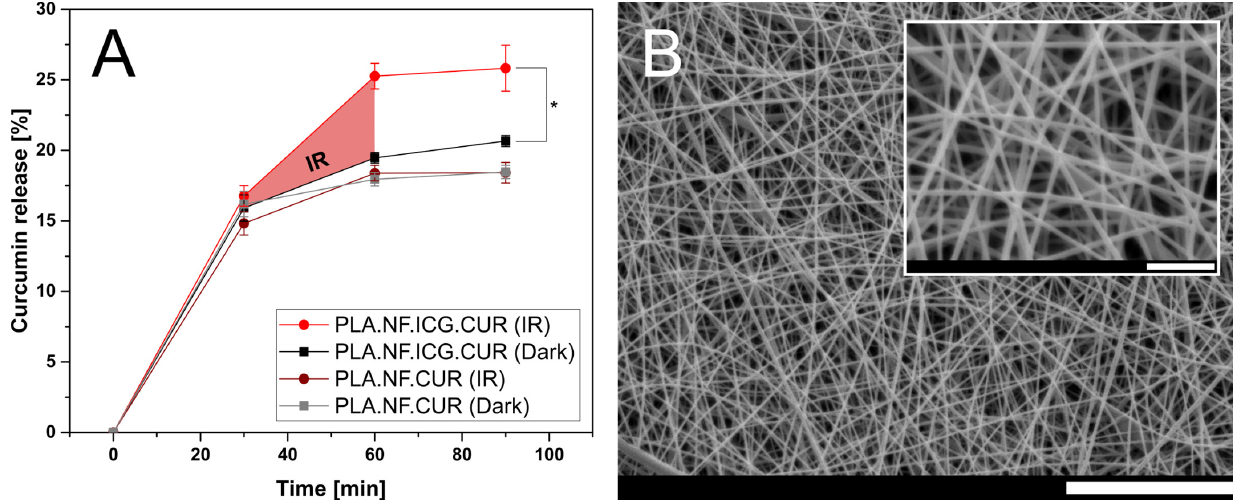
Figure 3. Curcumin release of PLA.NF.ICG.CUR and PLA.NF.CUR plotted as a function of time ( A ), Dark: 90 min incubation under light exclusion, IR: 30 min incubation, followed by 30 min irradiation (810 nm), and 30 min incubation. SEM micrographs of PLA.NF.ICG.CUR after irradiation ( B ). Scale bars represent 20 µm and 4 µm for the inset. Statistical differences are denoted as “*” p < 0.05.